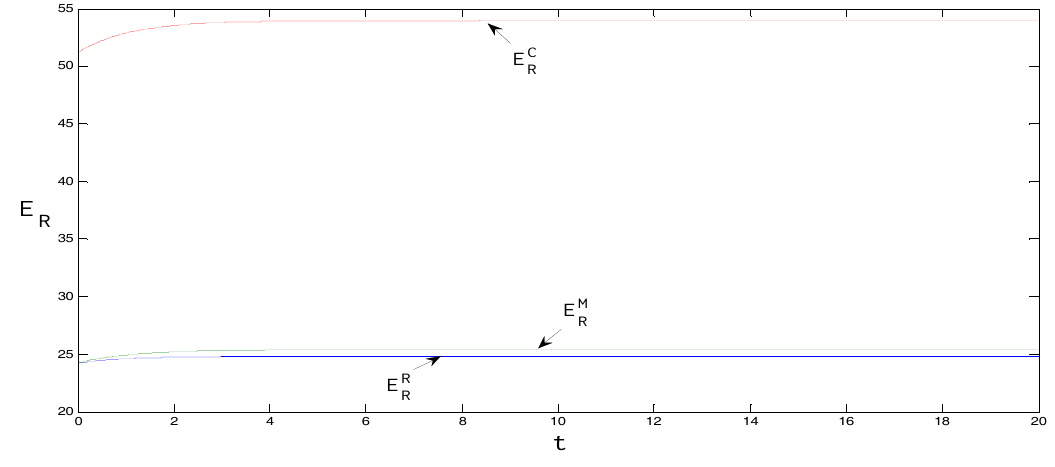
Figure 4. Comparison of promotional efforts.